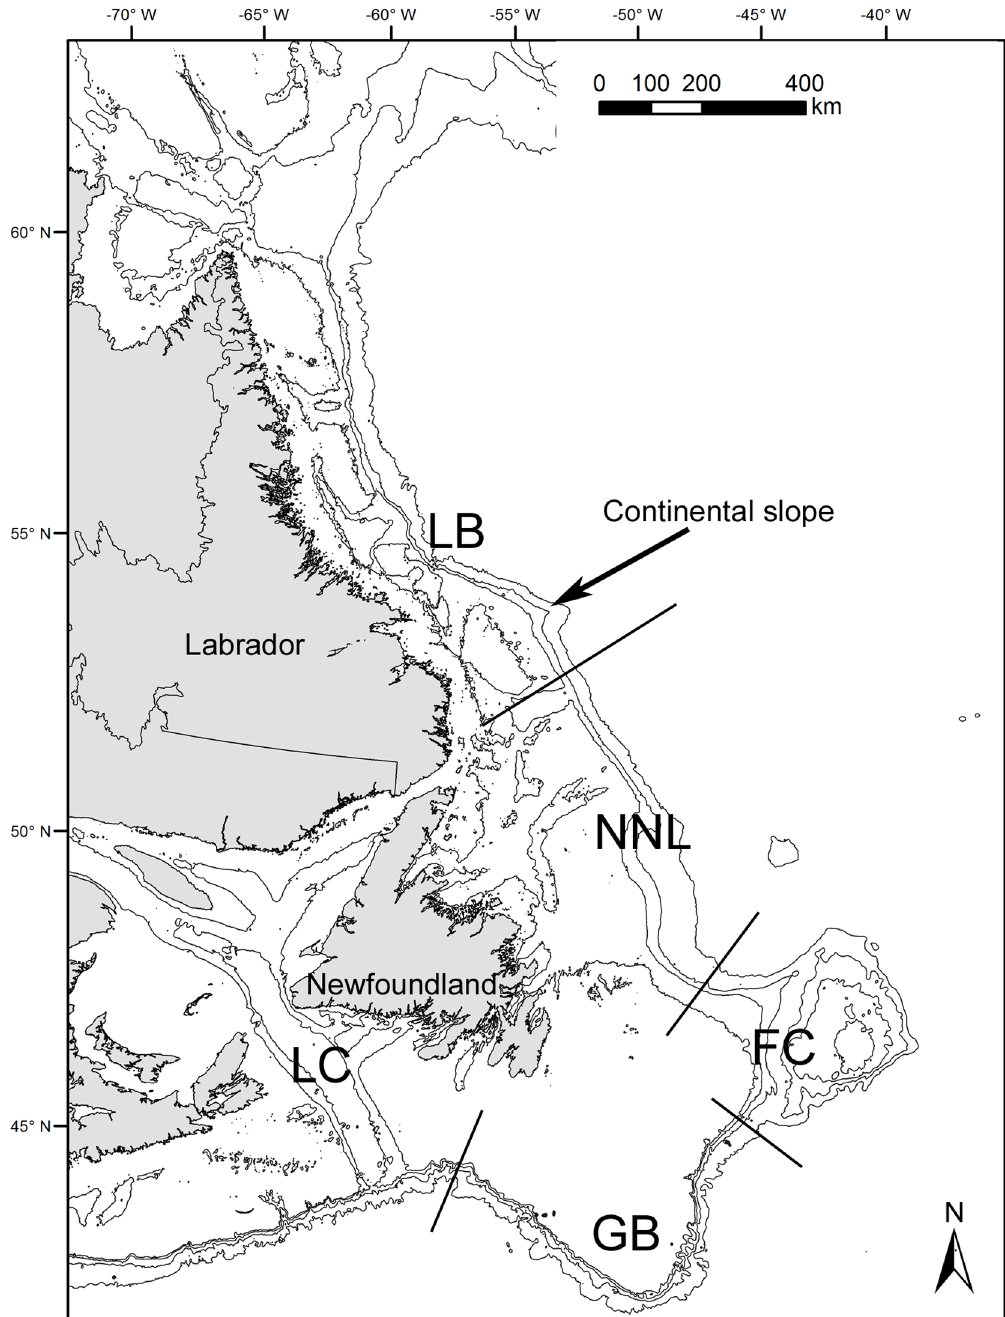
Figure 1. Map showing the five geographic regions where colonies of the sea pens Anthoptilum grandiflorum and Halipteris finmarchica were collected along the continental slope. LC: Laurentian Channel, GB: Grand Banks, FC: Flemish Cap, NNL: North Newfoundland, LB: Labrador.